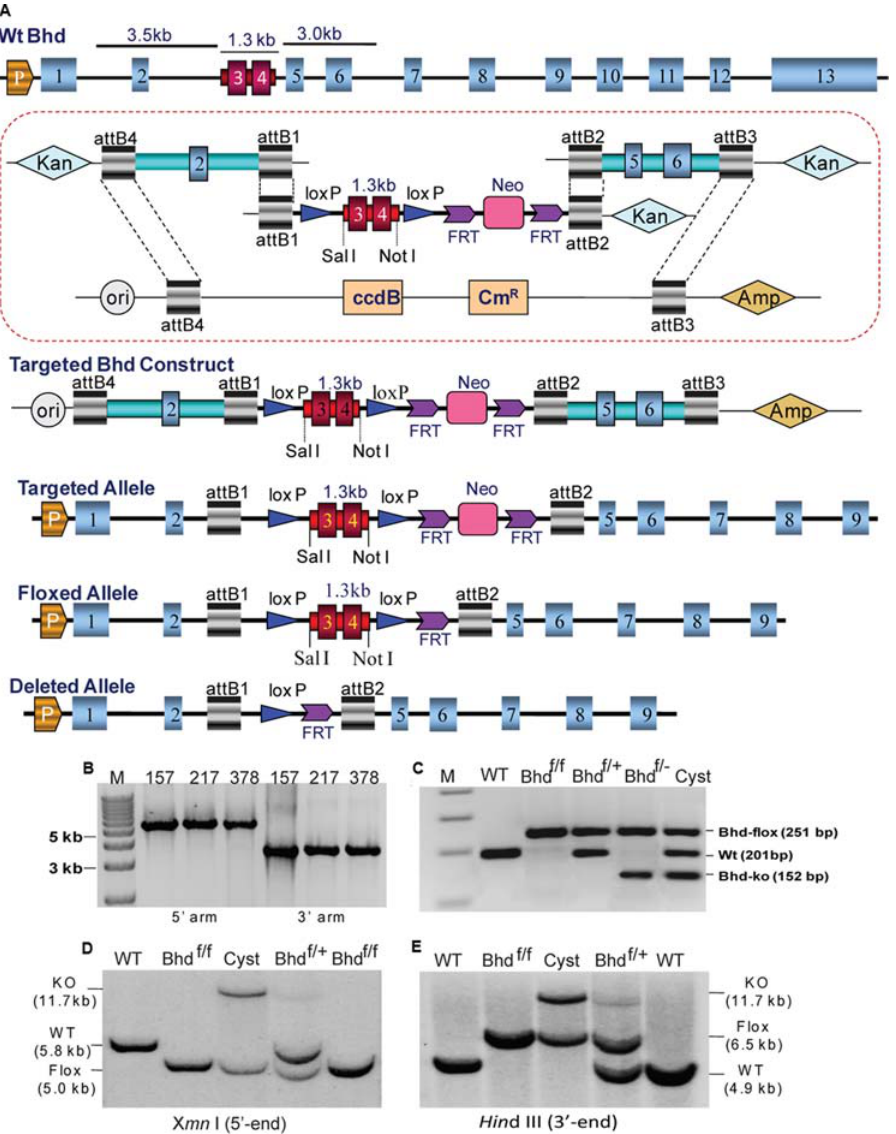
Figure 1. Targeting strategy and generation of BHD conditional knockout mice. (A) Construction of the BHD gene targeting vector using a combination of the Gateway and loxp systems. A 3.5-kb 5 9 homology arm containing exon 2 and a 3.0-kb 3 9 arm carrying exons 5 and 6 were integrated into the pDONR P4-P1R and pDONR P2R-P through a BP (attB and attP) reaction to generate the BHD -5 9 and BHD -3 9 homology entry clones, respectively. A 1.3-kb fragment of genomic DNA bearing exons 3 and 4 of the BHD gene was inserted to the modified pDONR vector pENTR3C- loxPMCS-loxP-FRT-neo-FRT between the Sal I and Not I sites to generate a BHD-exon3-4-pENTR3C entry clone. The three entry clones, in combination with the modified destination vector, were incubated to create a BHD-pDESTR4R3 targeting construct through BP recombination reaction. (B) Positive-targeting ES clones were selected by long-range PCR and confirmed by Southern blot analysis. (C) PCR genotyping of mouse offspring using tail DNA. (D, E) Knockout mice and normal controls were validated by Southern blot